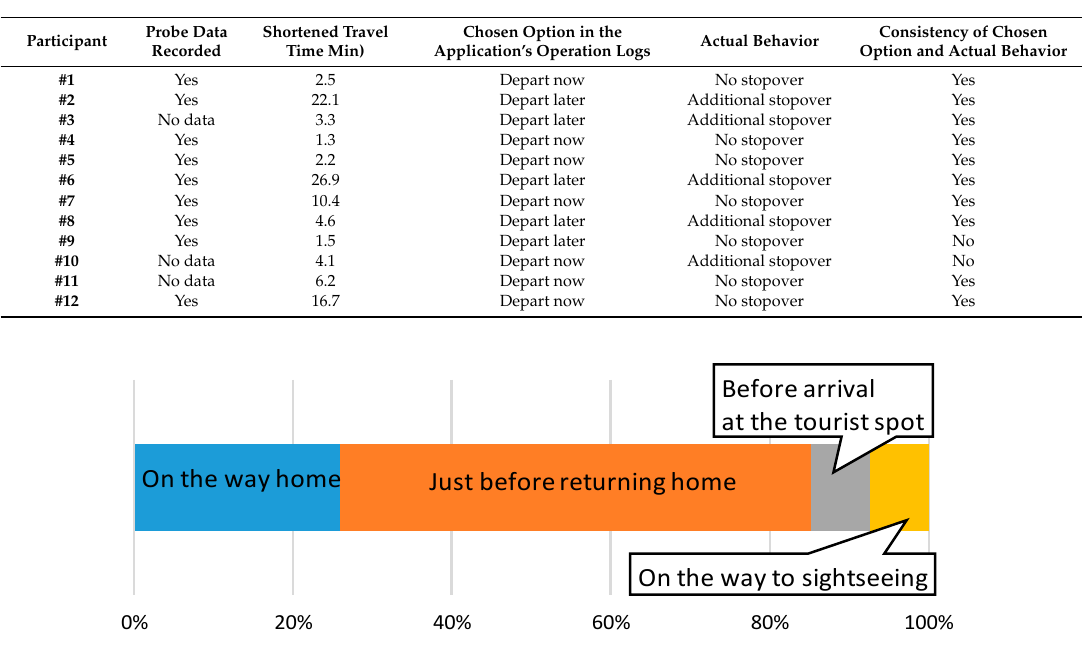
Table 3. Summary of operation logs and actual behavior of participants who answered the post-experiment questionnaire.